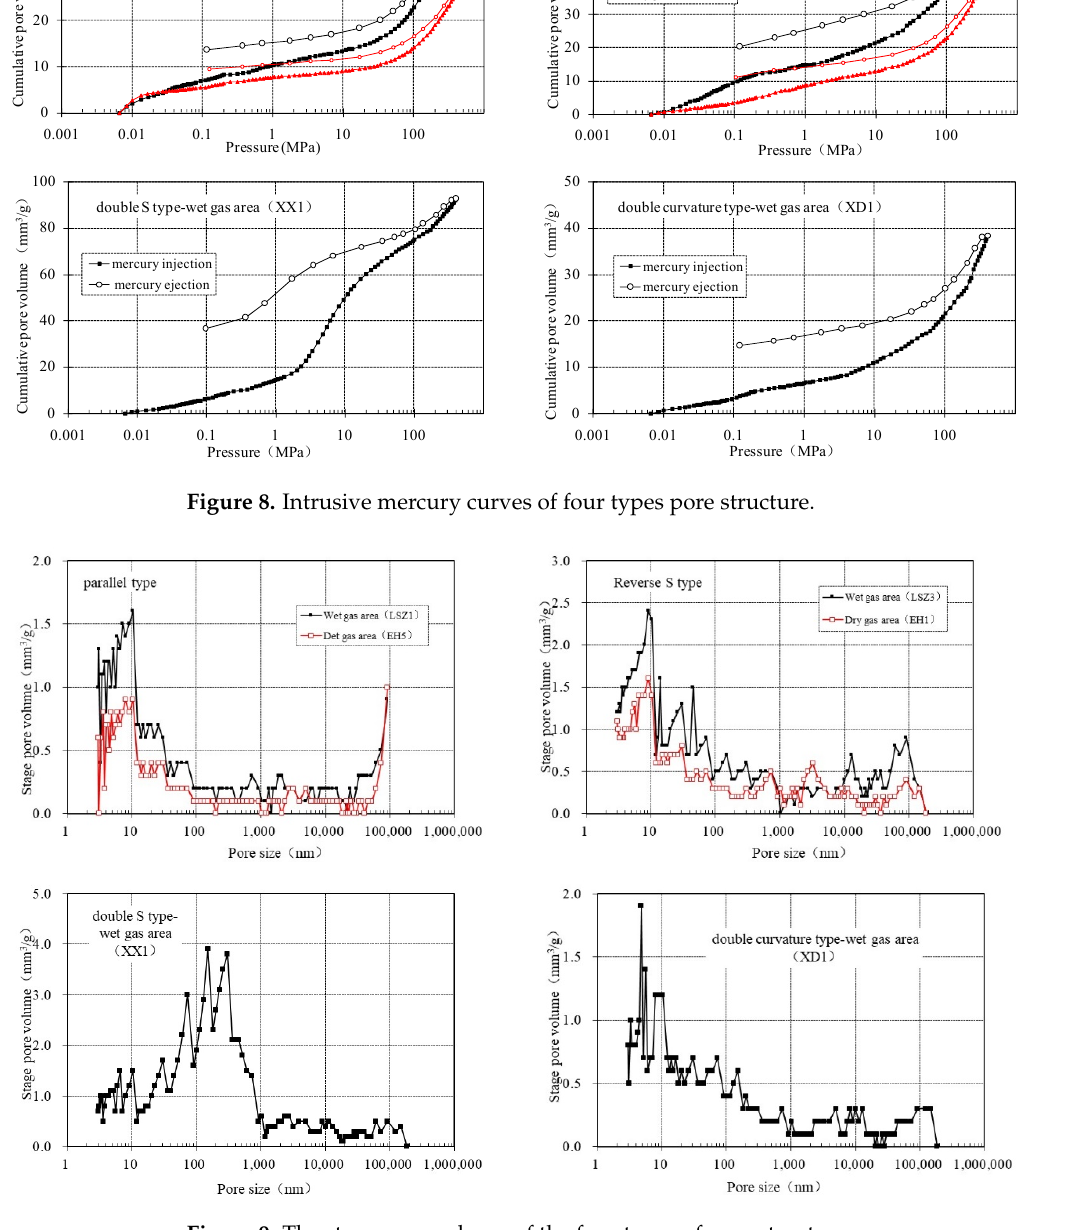
Figure 9. The stage pore volume of the four types of pore structure.